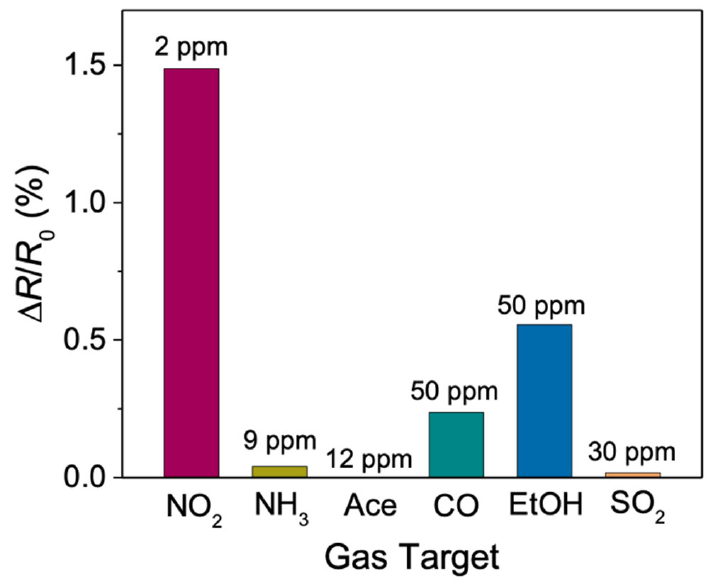
Figure 7. Histogram showing the percentage resistance variation of the Si NWs sensor for different gases tested.